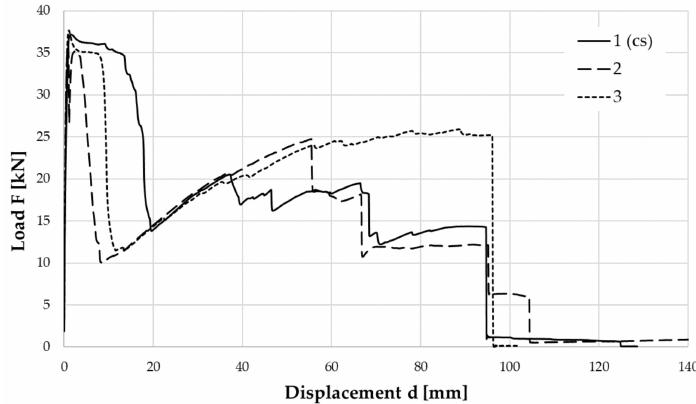
Figure 10. Tensile load-displacement response curves of samples 1, 2, 3 (G = 1.4 MPa).